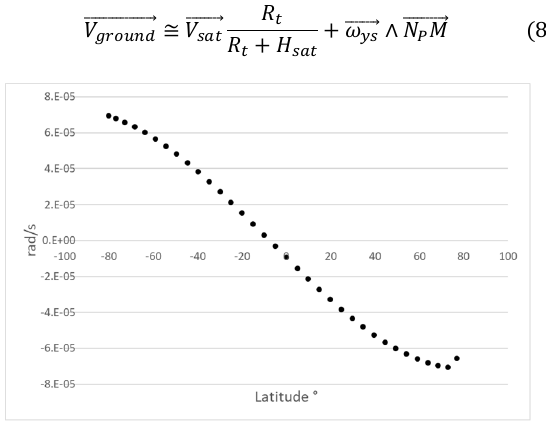
Figure 5 : Yaw speed dependence with satellite latitude.